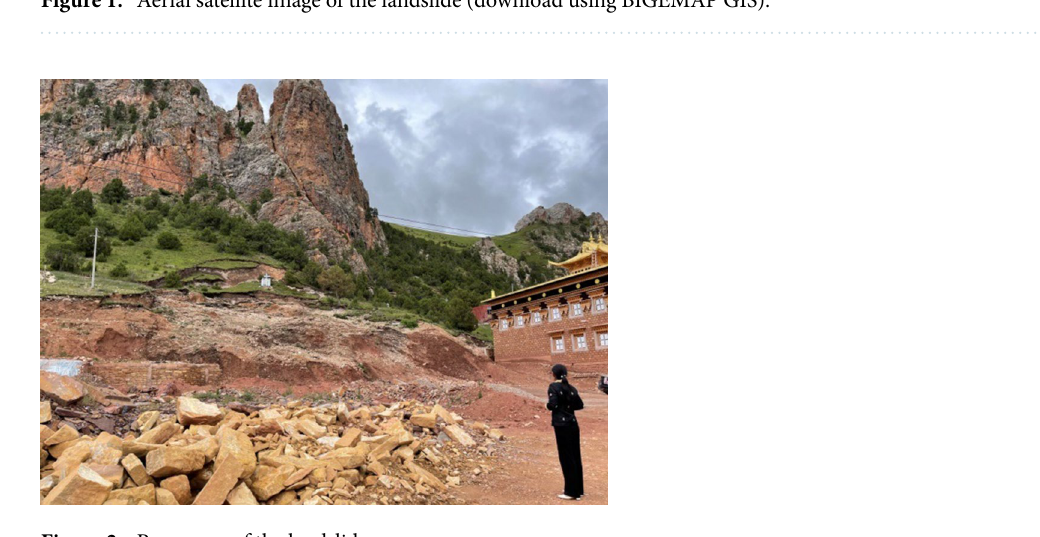
Figure 2. Panorama of the